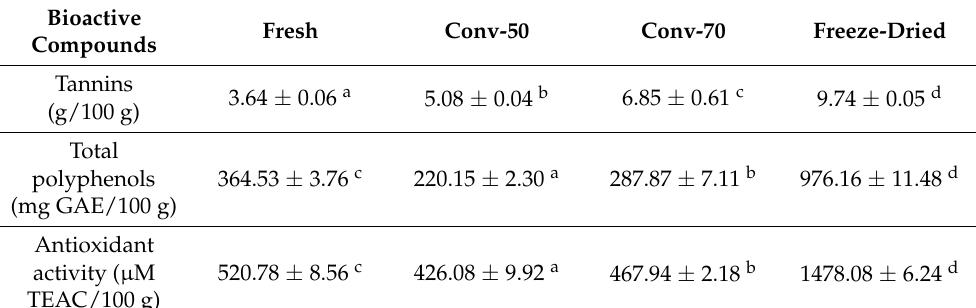
Table 6. The content of tannins, total polyphenols and antioxidant activity in fresh and dried quince